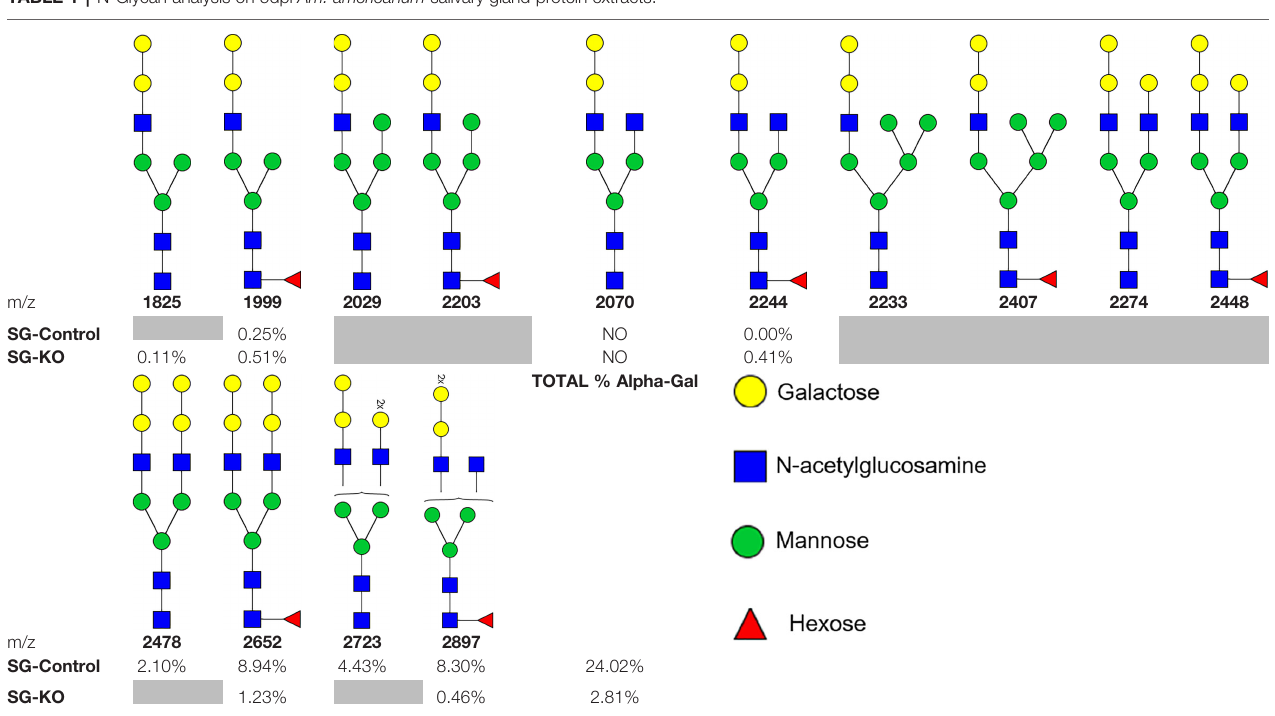
TABLE 1 | N-Glycan analysis on 5dpi Am. americanum salivary gland protein extracts.